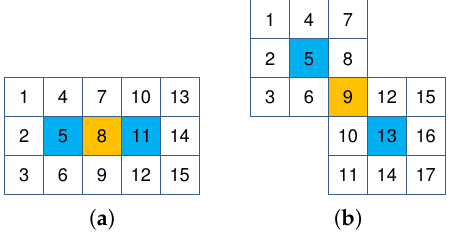
Figure 7. Neighborhood pixels for calculating gradient angle difference. ( a ) Column direction; ( b ) Diagonal